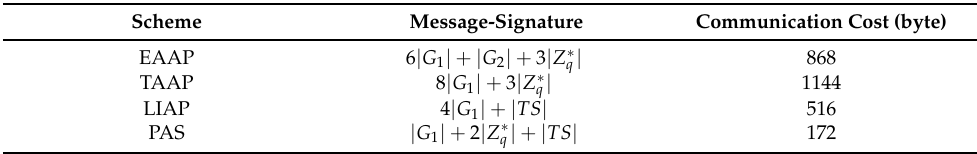
Table 5. The communication cost of each scheme.